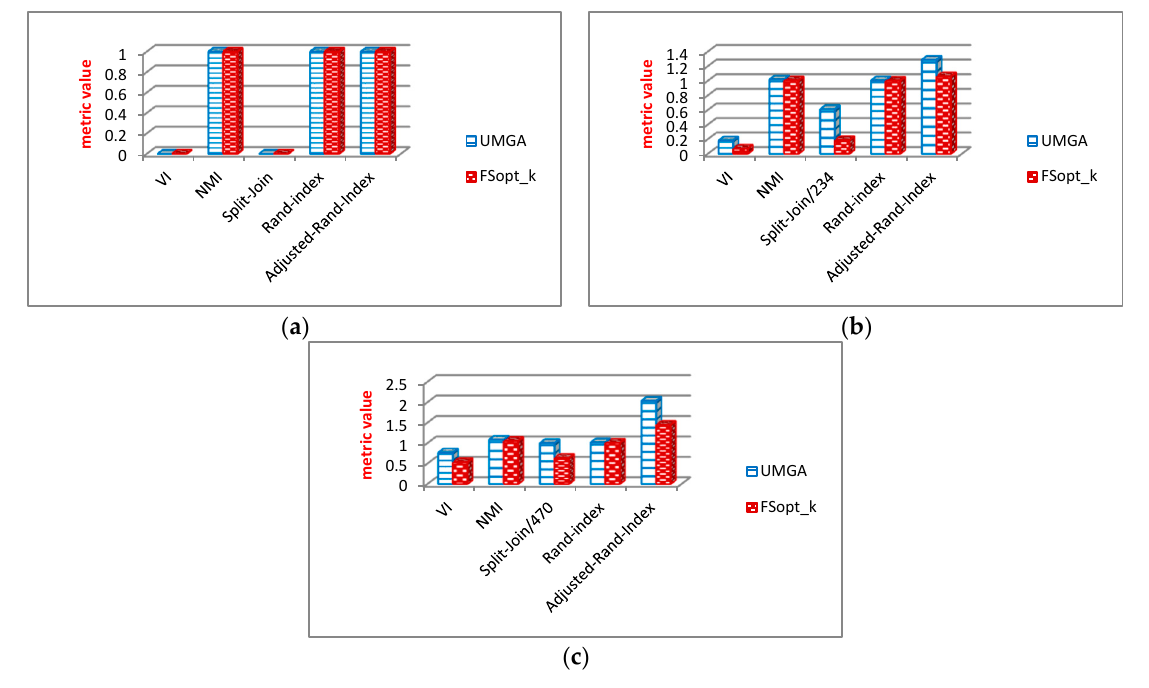
Figure 14. Evaluated values of community structure metrics on netscience for ( a ): ℒ = 0.05 , ( b ): ℒ = 0.1 , and ( c ): ℒ = 0.2 .